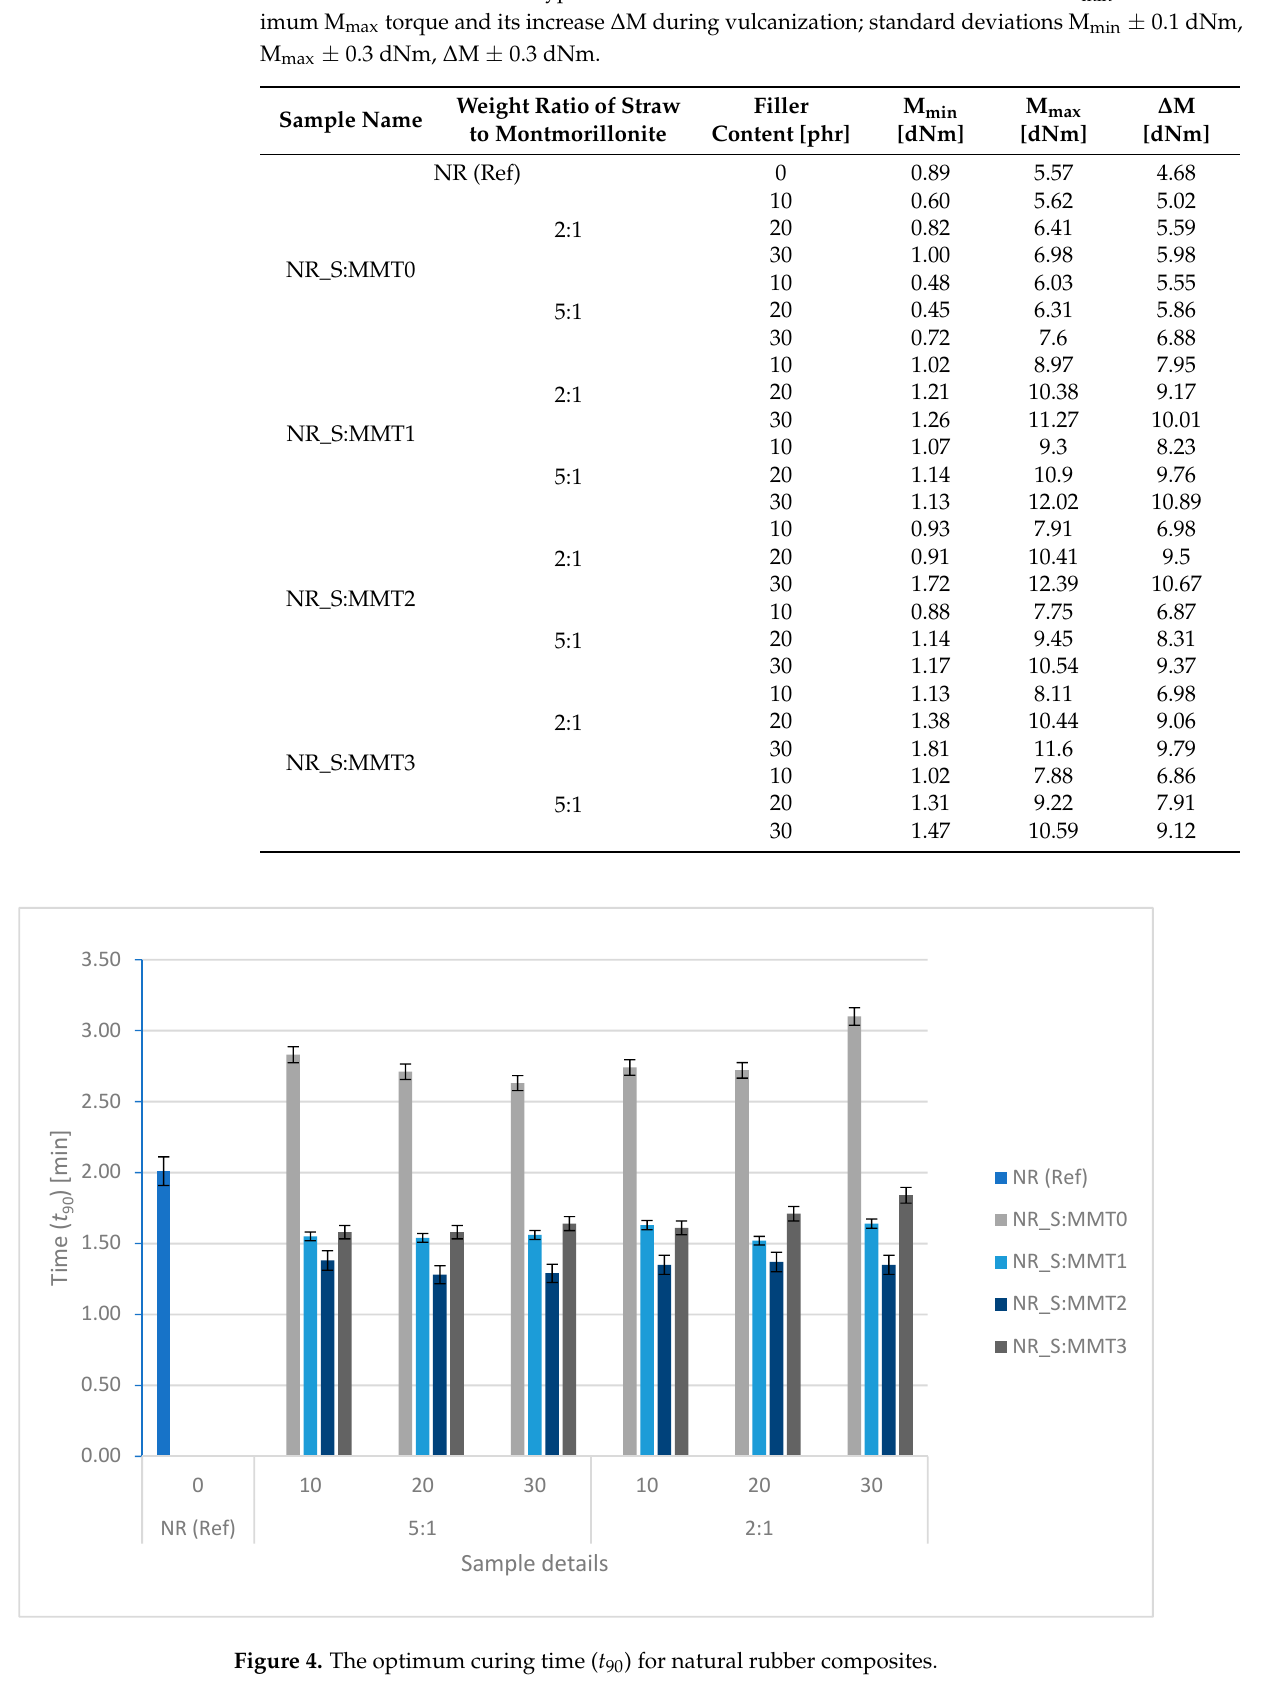
Table 5. The influence of the type and content of the biofiller used on the minimum M min and the max-